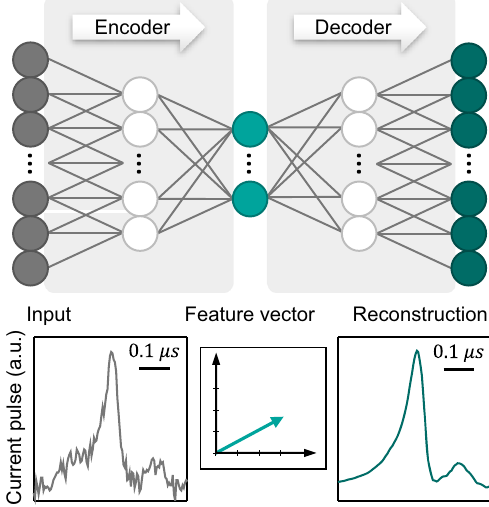
Fig. 4 Working principle of the autoencoder network. The symmet- ric network first encodes an input current-signal (left) into a low- dimensional feature vector (center) before decoding, i.e. reconstructing the input from the feature vector